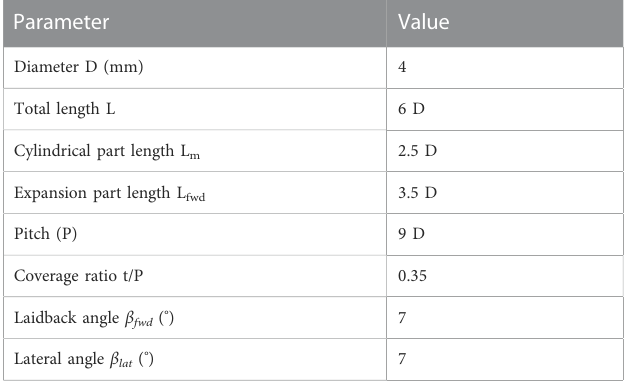
TABLE 1 Geometrical parameters of seven-to-seven fi lm-cooling